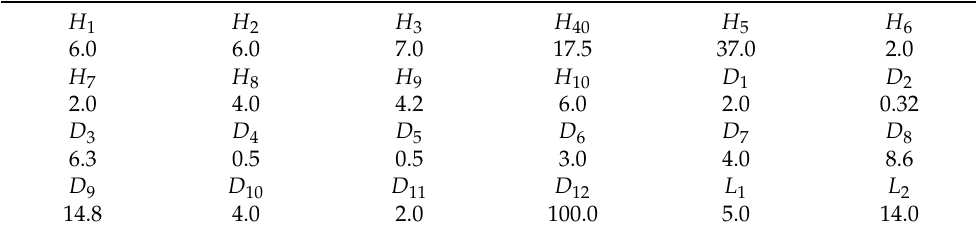
Figure 2. ( a ) Simulated results of |S 11 | versus the variation of EGaIn column H 40 and the height of the cylinder of temperature-sensitive bulb H 2 . ( b ) Simulated results of |S 11 | versus the variation of the height of the cone of temperature-sensitive bulb H 3 . Table 1. Dimensions of the Optimized Antenna (Unit: